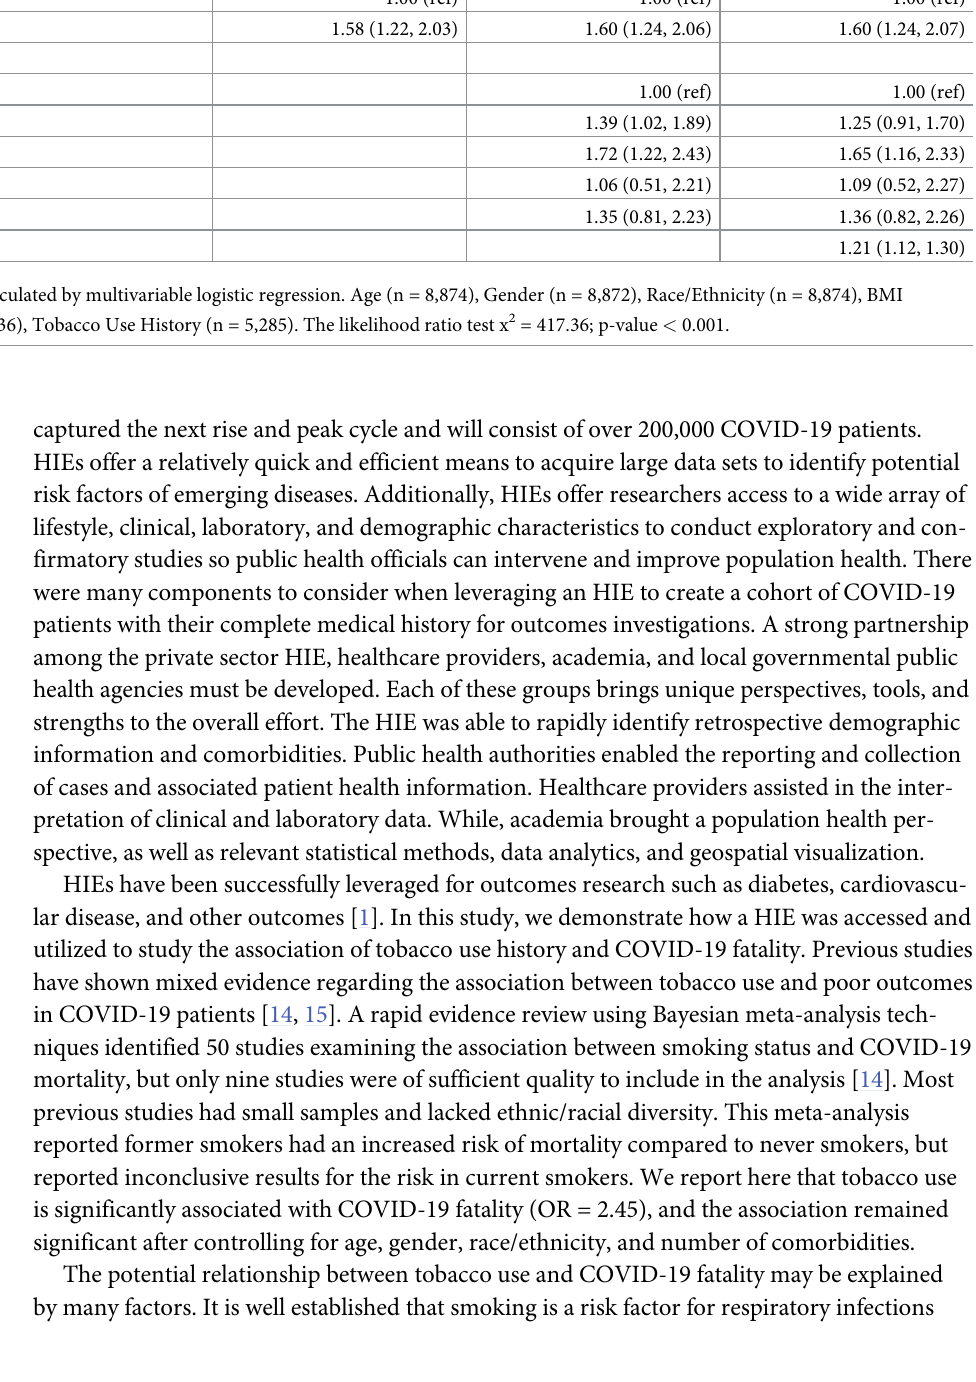
Table 2. Multivariable Logistic Analysis between risk factors associated with COVID-19 fatality.